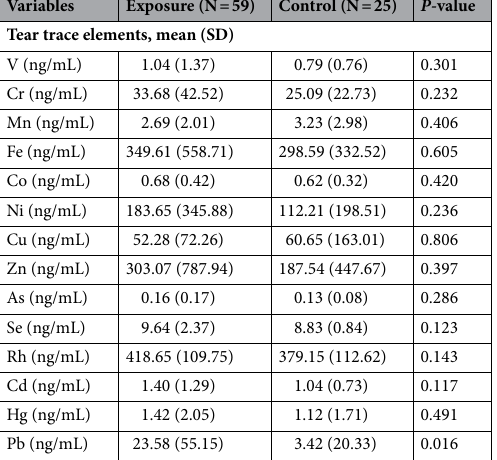
Table 2. Characteristics of tear trace elements. SD, standard deviation; V, vanadium; Cr, chromium; Mn, manganese; Fe, iron; Co, cobalt; Ni, nickel; Cu, copper; Zn, zinc; As, arsenic; Se, selenium; Rh, rhodium; Cd, cadmium; Hg, mercury; Pb, lead.